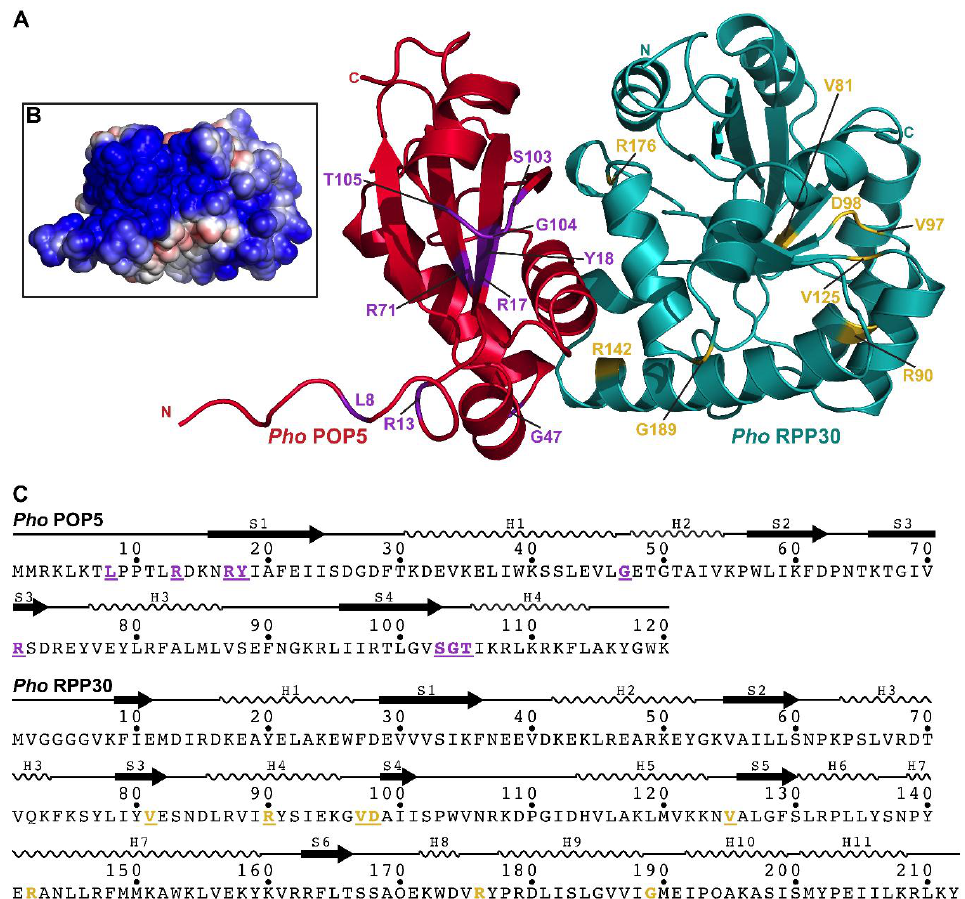
Figure 3. Highly conserved residues in Pho POP5 and RPP30. ( A ) Tertiary structure of the Pho POP5•RPP30 binary complex (PDB: 2CZV [23]). All positions with ≥80% or ≥75% identity from the alignment of 71 representative archaeal POP5 and RPP30 sequences, respectively, are highlighted; ( B ) Electrostatic potential map of the surface of the POP5•RPP30 complex; the orientation is identical to that in panel A; ( C ) Location of conserved residues (underlined and using the same color scheme as in (A)) and secondary structure elements in the sequences of POP5 and RPP30.